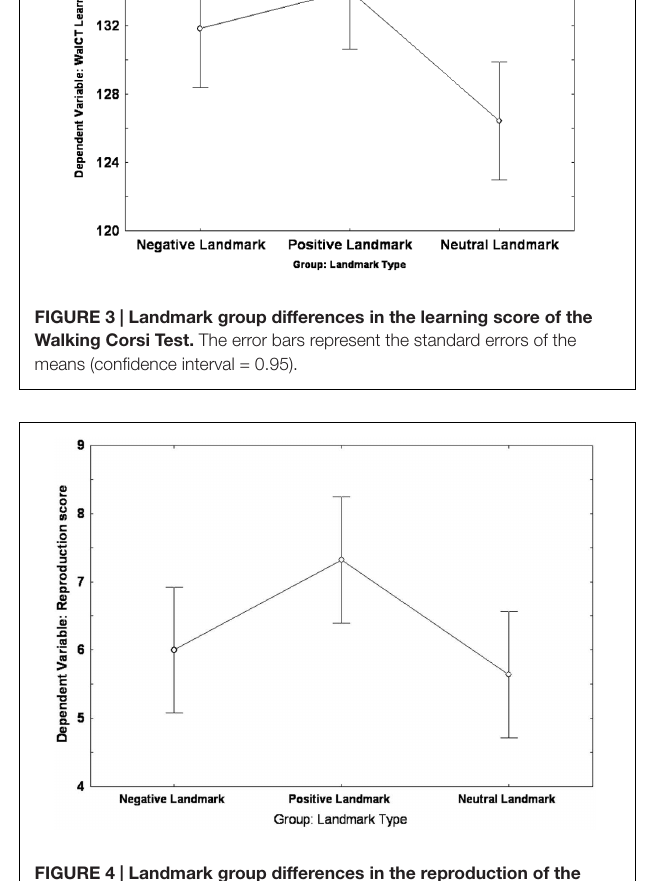
FIGURE 4 | Landmark group differences in the reproduction of the Walking Corsi Test. The error bars represent the standard errors of the means (confidence interval =